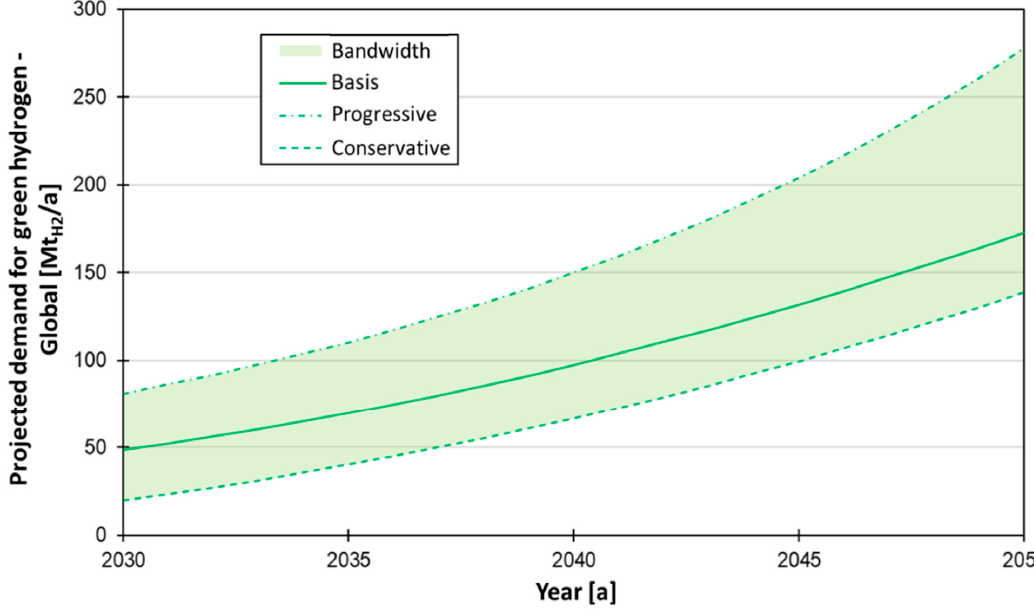
Figure 1. Forecasted development of global green hydrogen demand. Values are based on an evaluation of [6–9].